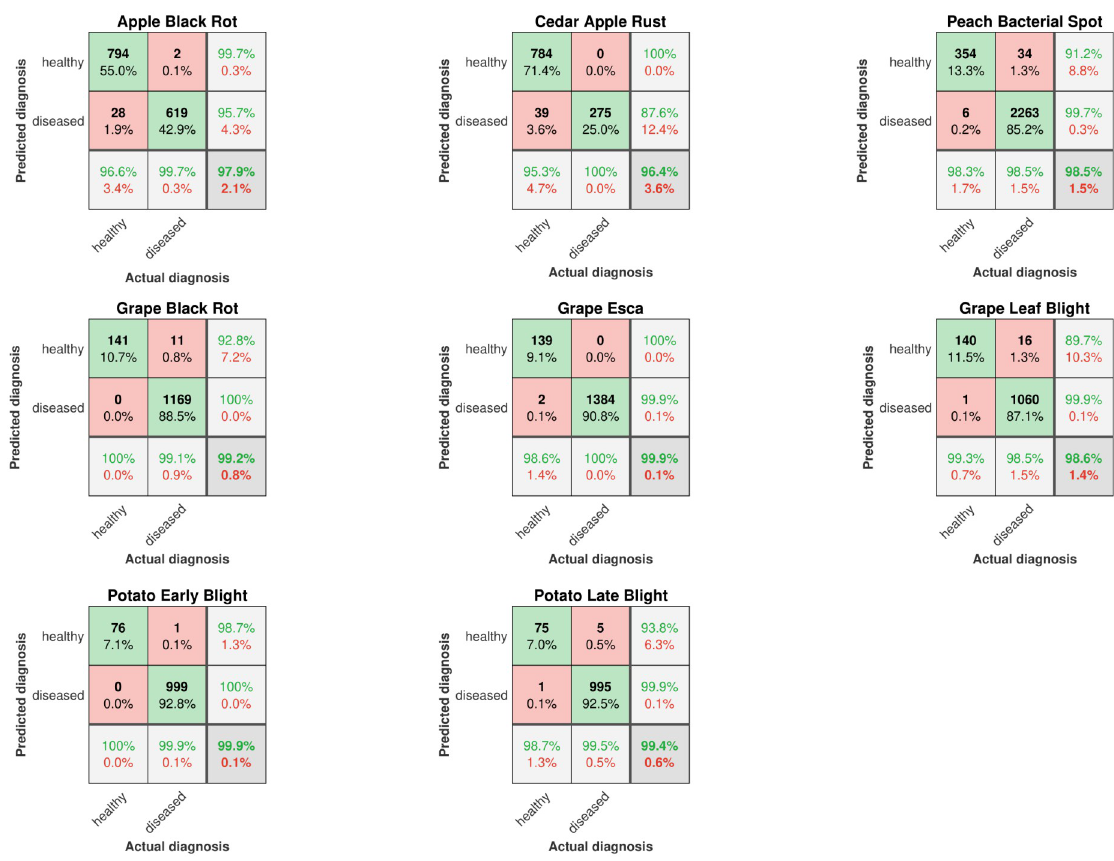
Fig 7. Confusion matrices for the proposed disease detection method.